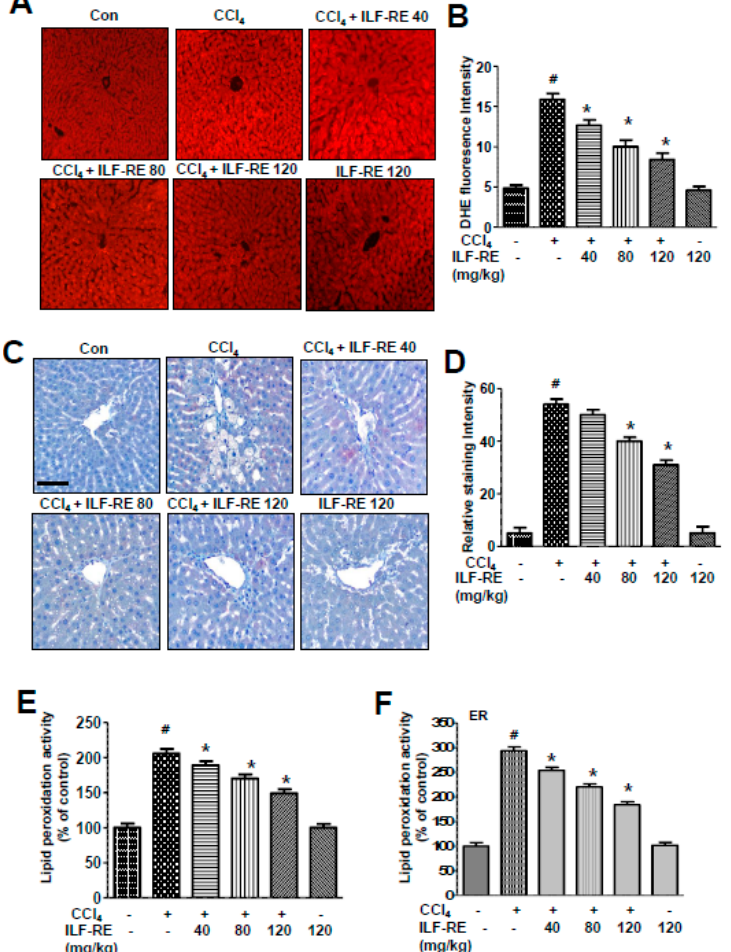
Figure 5. ILF-RE regulates ROS accumulation in CCl 4 -induced hepatotoxicity. Rats were intraperitoneally administered CCl 4 (0.2 mL/100 g, BW) twice a day for 4 weeks. ILF-RE (40, 80, or 120 mg/kg) was co-administered with CCl 4 or 120 mg/kg ILF-RE only for 4 weeks, followed by harvesting of the livers. DHE staining ( A ) and quantification assays ( B ) were performed using the livers from these rats. 4-HNE staining was performed ( C ), and the staining intensity of 4-HNE-positive cells was determined ( D ). Lipid peroxidation was assayed in the livers of these rats ( E ) and in the ER fractions from the liver tissues ( F ). The experiments were performed in triplicate using tissues from at least three rats in each group. # p < 0.05 vs. Con group; * p < 0.05 vs. CCl 4 group ( n = 10 rats per